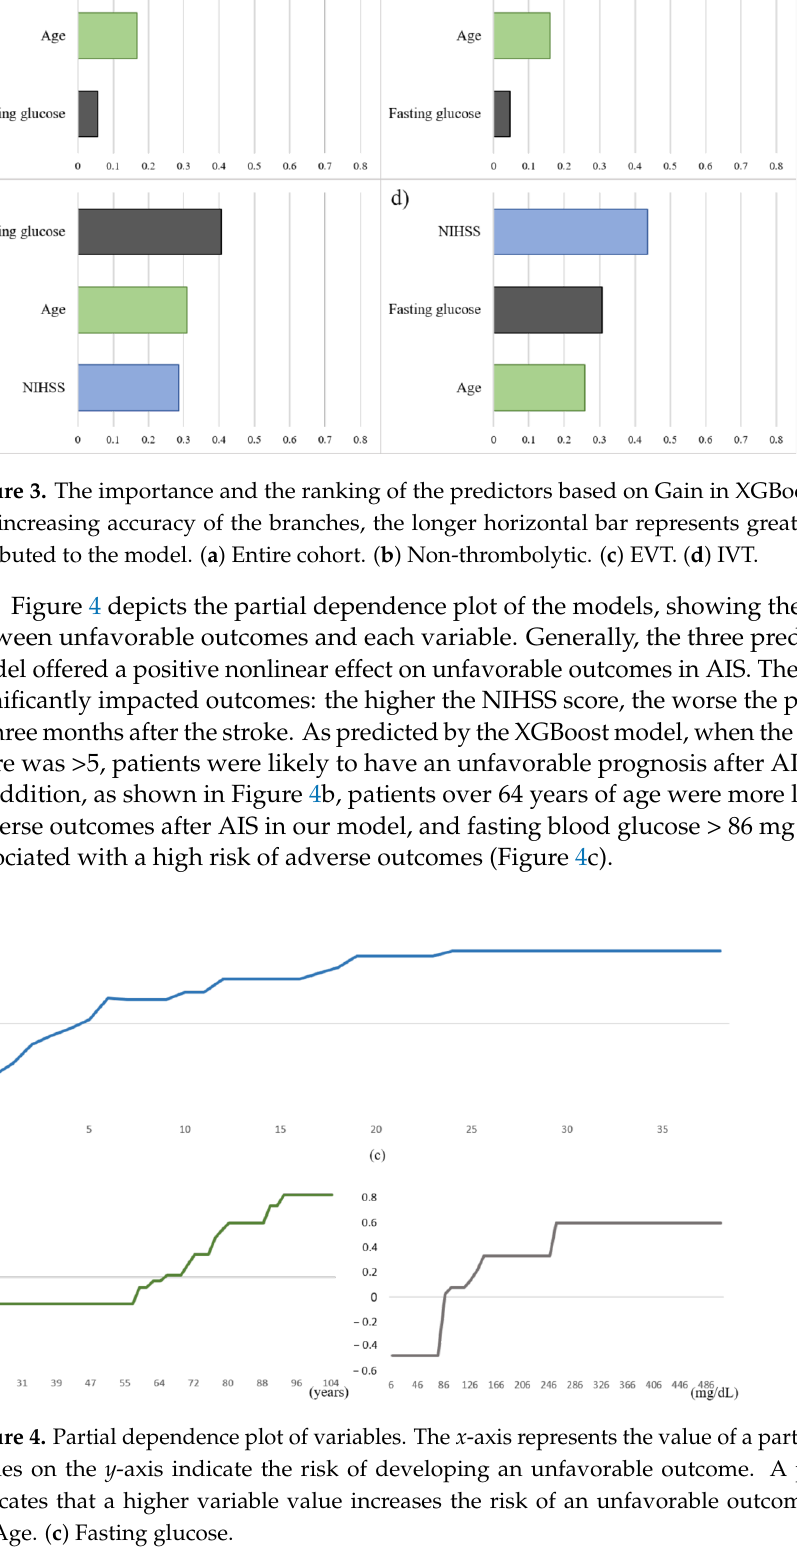
Figure 2. ROC curves of ten-fold cross-validation based on XGBoost.